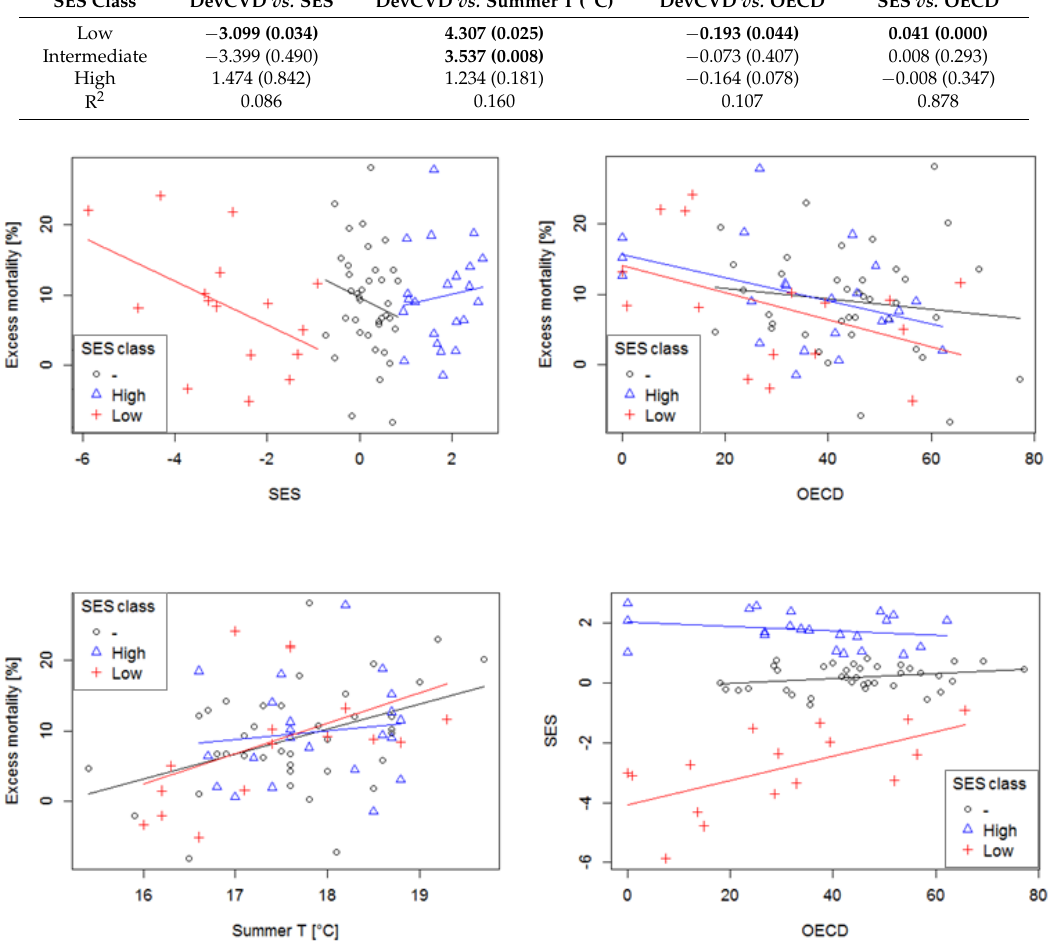
Figure 5. Scatterplots comparing mean relative excess mortality due to CVDs on hot days ( DevCVD ) with index of socioeconomic status ( SES ), percentage of rural population ( OECD criterion), and mean summer temperature ( Summer T ) for districts with low (< − 0.50 StdDev), intermediate (-), and high (>0.50 StdDev) socioeconomic status ( SES ). Coefficients of regression lines are reported in Table 4. See Table 1 for description of variables examined.